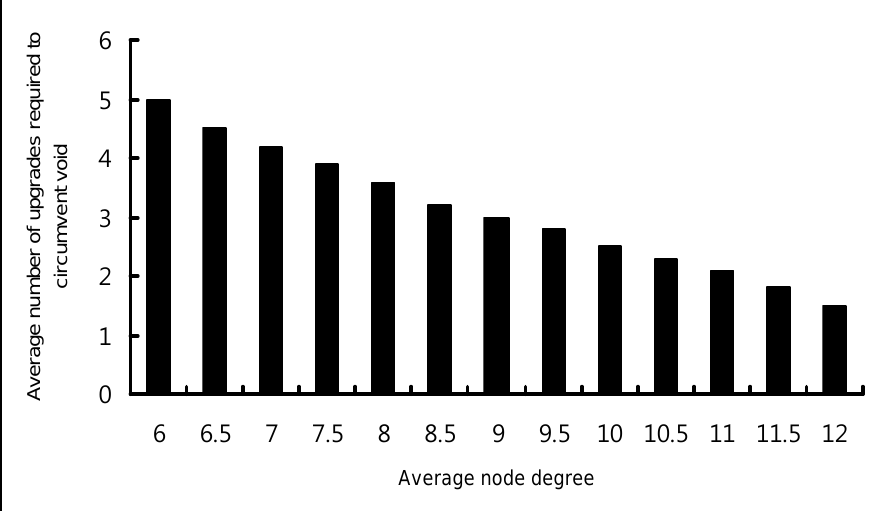
Figure 23. Average number of upgrades required to circumvent voids with different average node